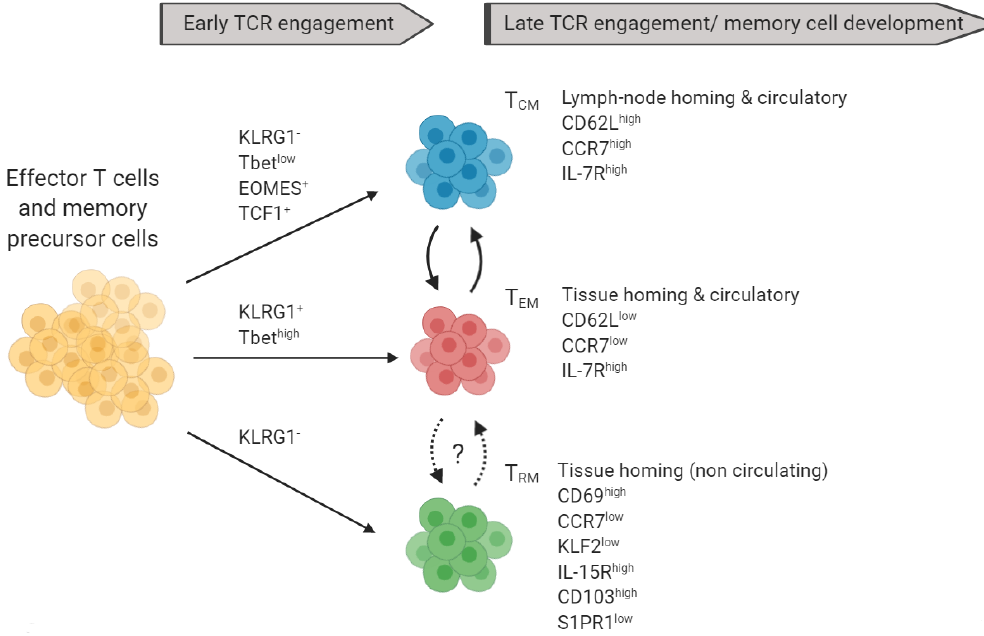
Figure 3. Markers of memory T cell subsets and their precursors: Terminally differentiated T CM (blue) and T EM (red) can be distinguished based on the expression of CD62L, CCR7, IL7R, and other markers not shown. T RM can be further characterized based on the expression of KLF2, IL-15R, CD103, and S1PR1. T CM can give rise to T EM and vice versa. *Recent data suggested that T RM can re-enter the